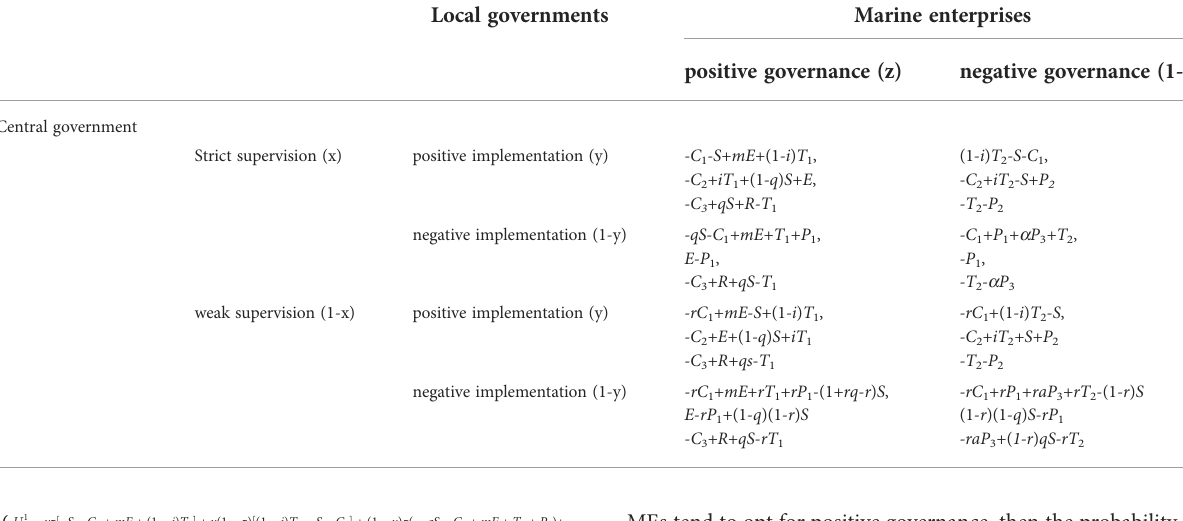
TABLE 2 Three-party subject game payment